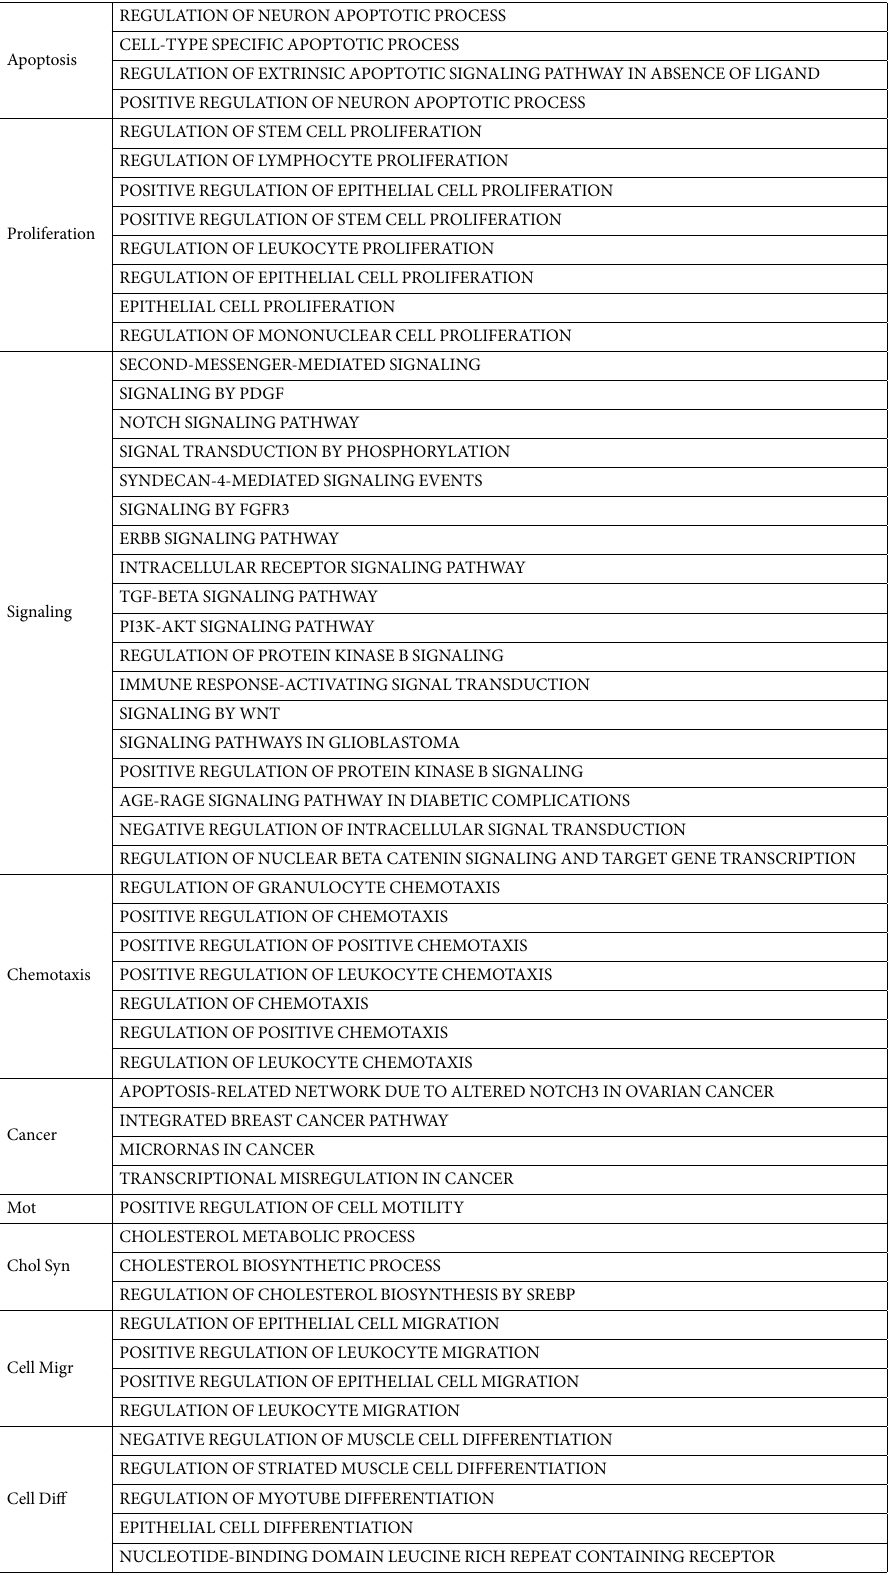
Table 1. Pathways and their categories of the miRNA target enriched genes and the pathways effected by these